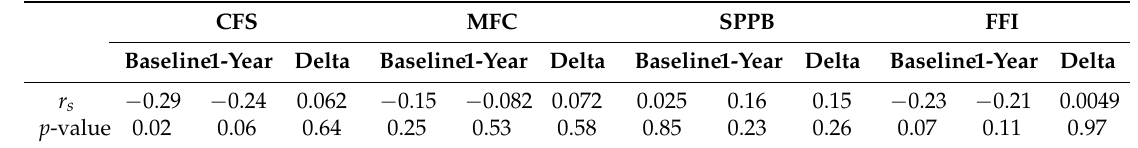
Table 4. Correlations between CR attendance and